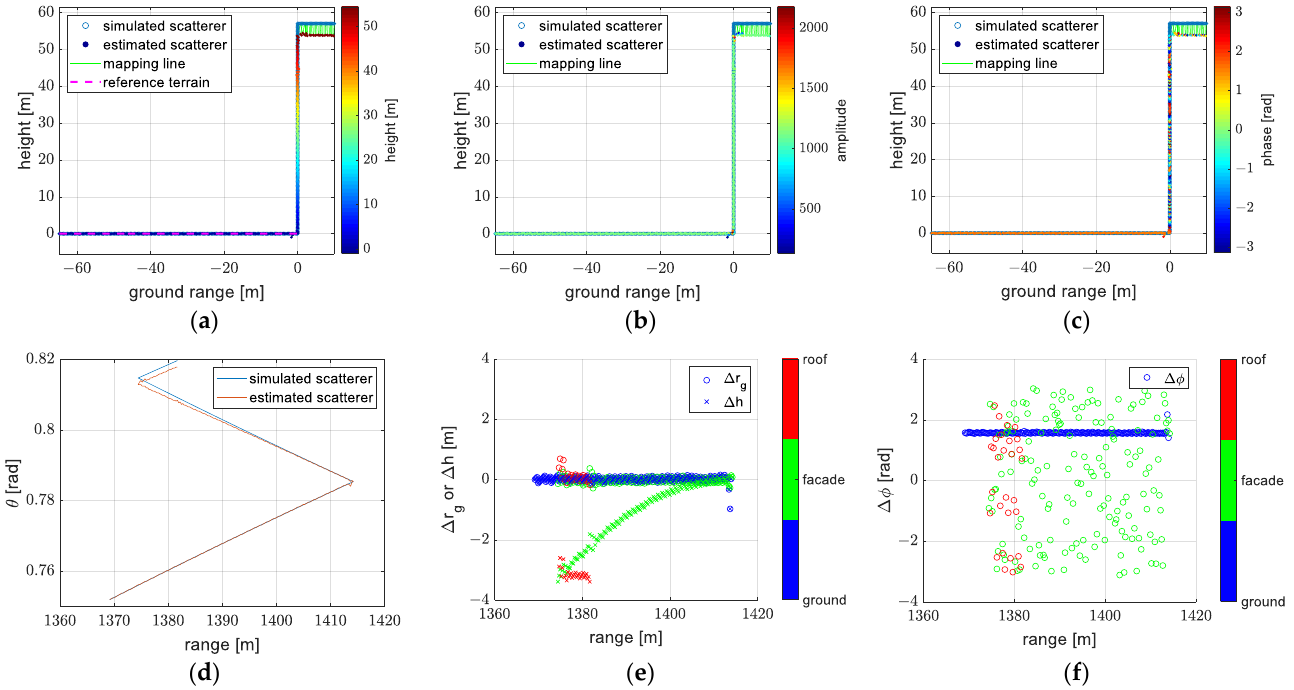
Figure 12. The reconstruction obtained using model 3 (the second approximate form of the planar wavefront model): ( a ) reconstruction with colors denoted as height, ( b ) reconstruction with colors denoted as amplitude, ( c ) reconstruction with colors denoted as phase, ( d ) the off-nadir angle of the reconstruction, ( e ) the error of the ground range and height, ( f ) the error of the phase.